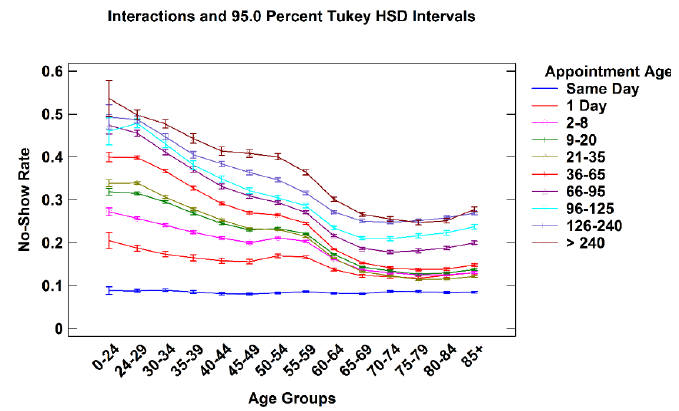
Figure 6. No-show rates for all appointment age groups by patient age.